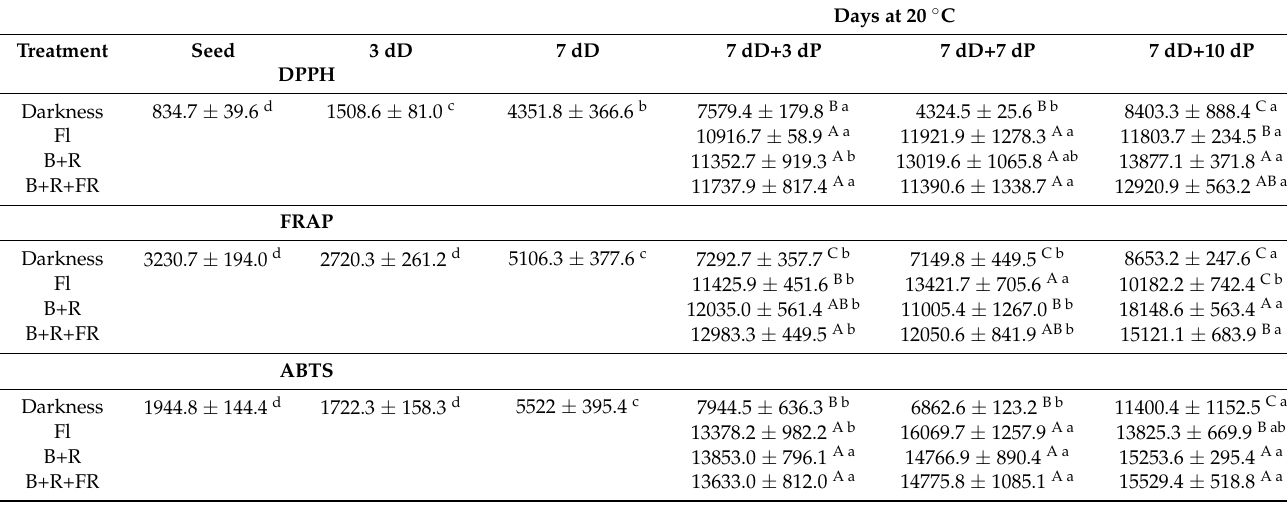
Table 2. Total antioxidant activity (mg TE kg − 1 dw) of carrot sprouts grown at 20 ◦ C during 7 days in darkness (dD)+3 or 7 or 10 days of a 16 h/8 h photoperiod (dP) under several light